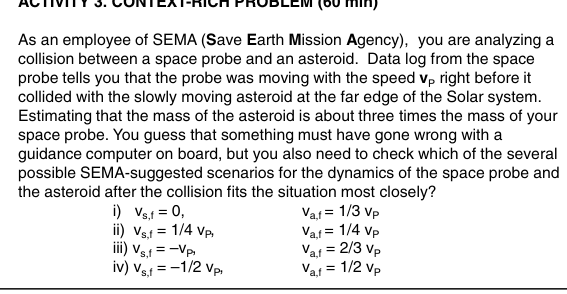
FIG. 6. An example sequence of activities in a CWP session, in this case for instruction on linear